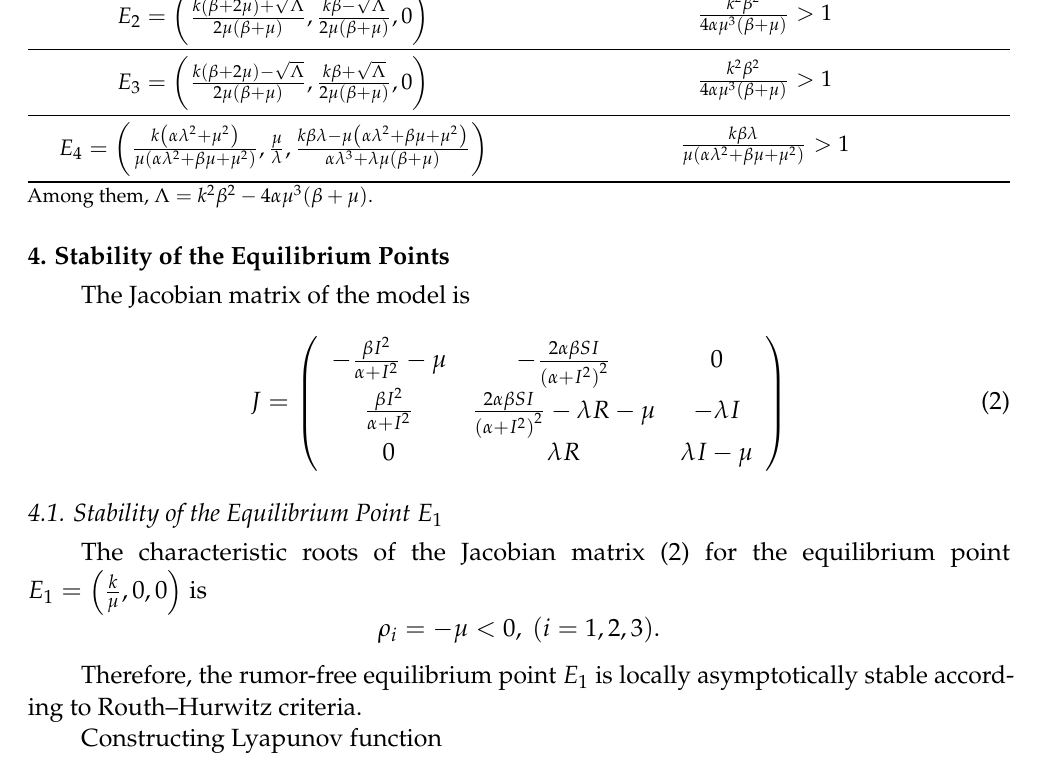
Table 1. The condition for the existence of the four equilibrium points. The Equilibrium Point (cid:16) (cid:17) k E 1 = ,0,0 µ